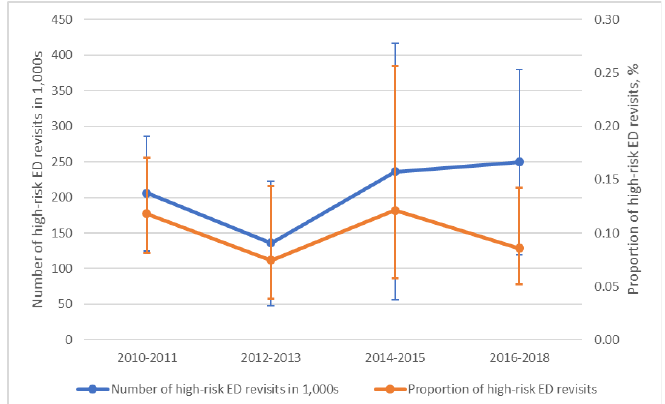
Figure 3. The number and proportion of overall emergency department high-risk revisits, 2010-2018. The error bars represent 95% confidence intervals.